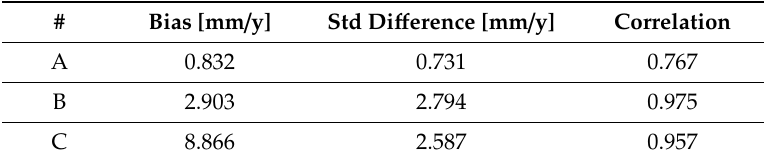
Table 1. Cross validation of the two multi-temporal outputs used for the S1 data processing methods. The values are relative to the total component of the deformation rate in the LOS of S1 on the ascending path. The same comparison could not be made for the descending path because of the lack of CSK images on that